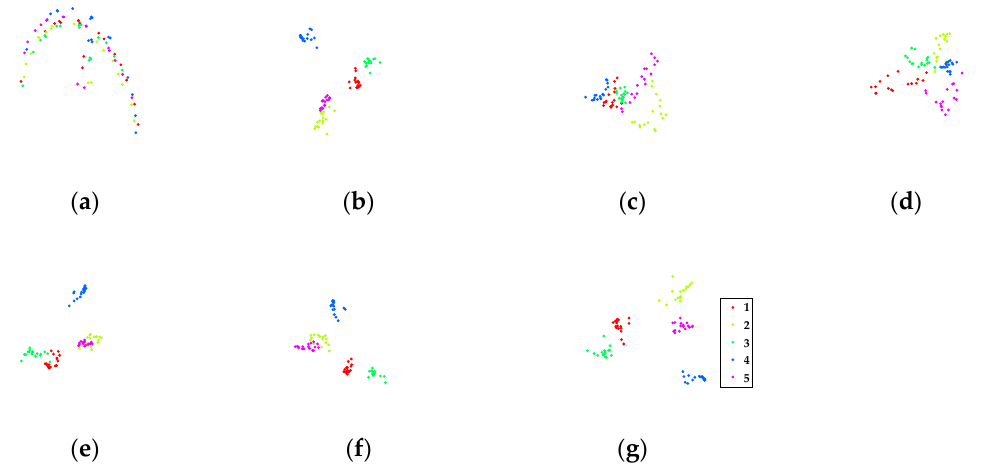
Figure 6 . Two-dimensional five-class CMU PIE data projected by different DR methods. ( a ) PCA; ( b ) LDA; ( c ) MMC; ( d ) SGDA; ( e ) LGDA; ( f ) SLGDA; ( g ) BLSE.